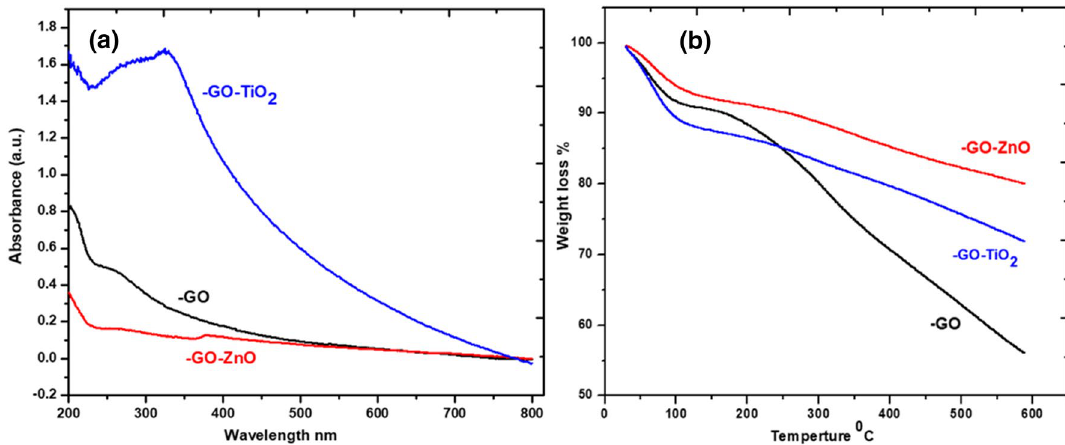
Fig. 2 a UV-absorbance and b TGA spectra of GO, GO-ZnO and GO-TiO